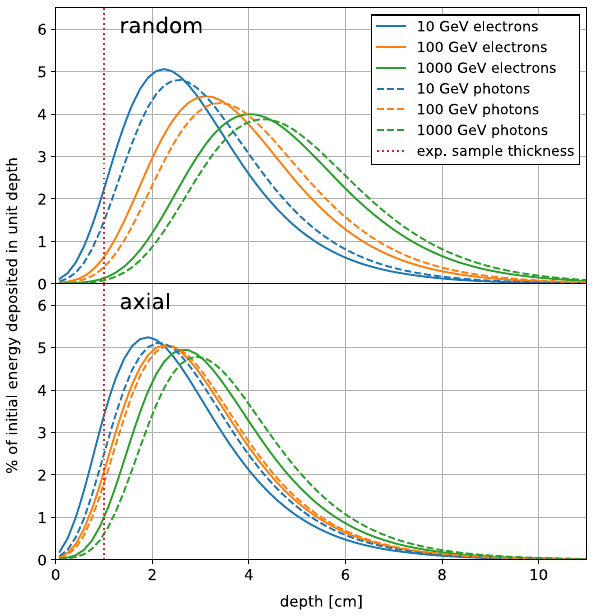
Fig. 4 Simulated energy absorbed in crystalline tungsten oriented along the (cid:2) 111 (cid:3) axis, normalized to the primary particle energy and to the unit depth, as a function of the depth inside the crystal, for incident electrons (solid curves) and photons (dashed curves). The simulated crystal parameters are the same as in the experimental case presented in Figs. 2 and